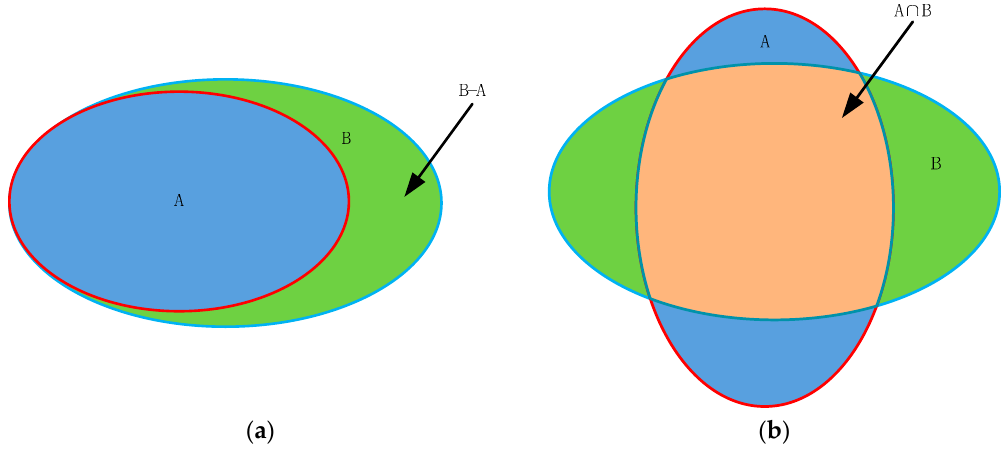
Figure 19. The effect of the maximum pooling-minimum expected height method. The acceleration effect of plane area was more obvious.